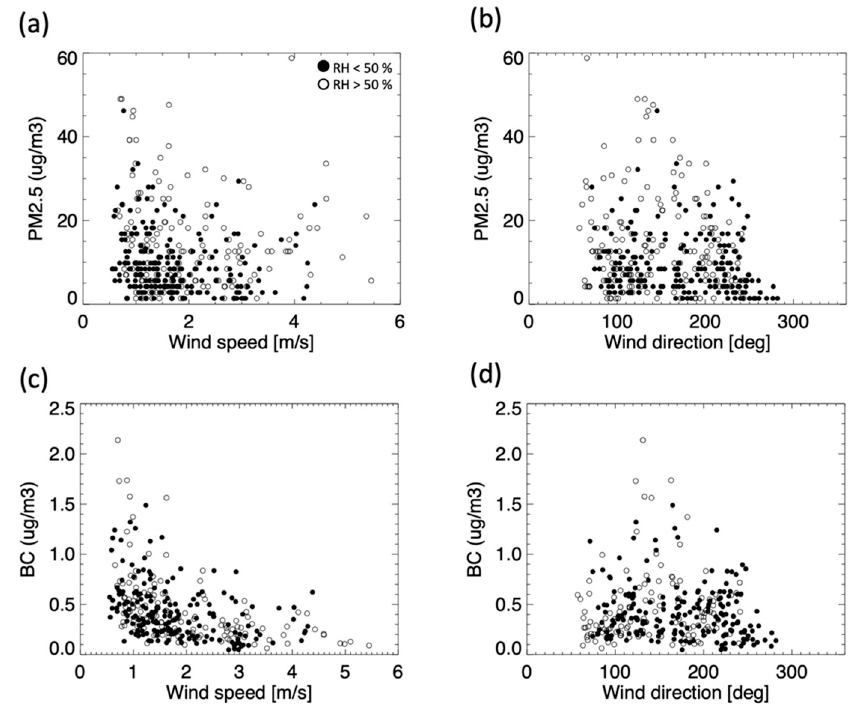
Figure 3. Scatter plots of daily surface PM2.5 mass concentrations relative to wind speed ( a ) and wind direction ( b ); scatter plots of BC relative to wind speed ( c ) and wind direction ( d ). Filled black circles highlight days with RH < 50%.